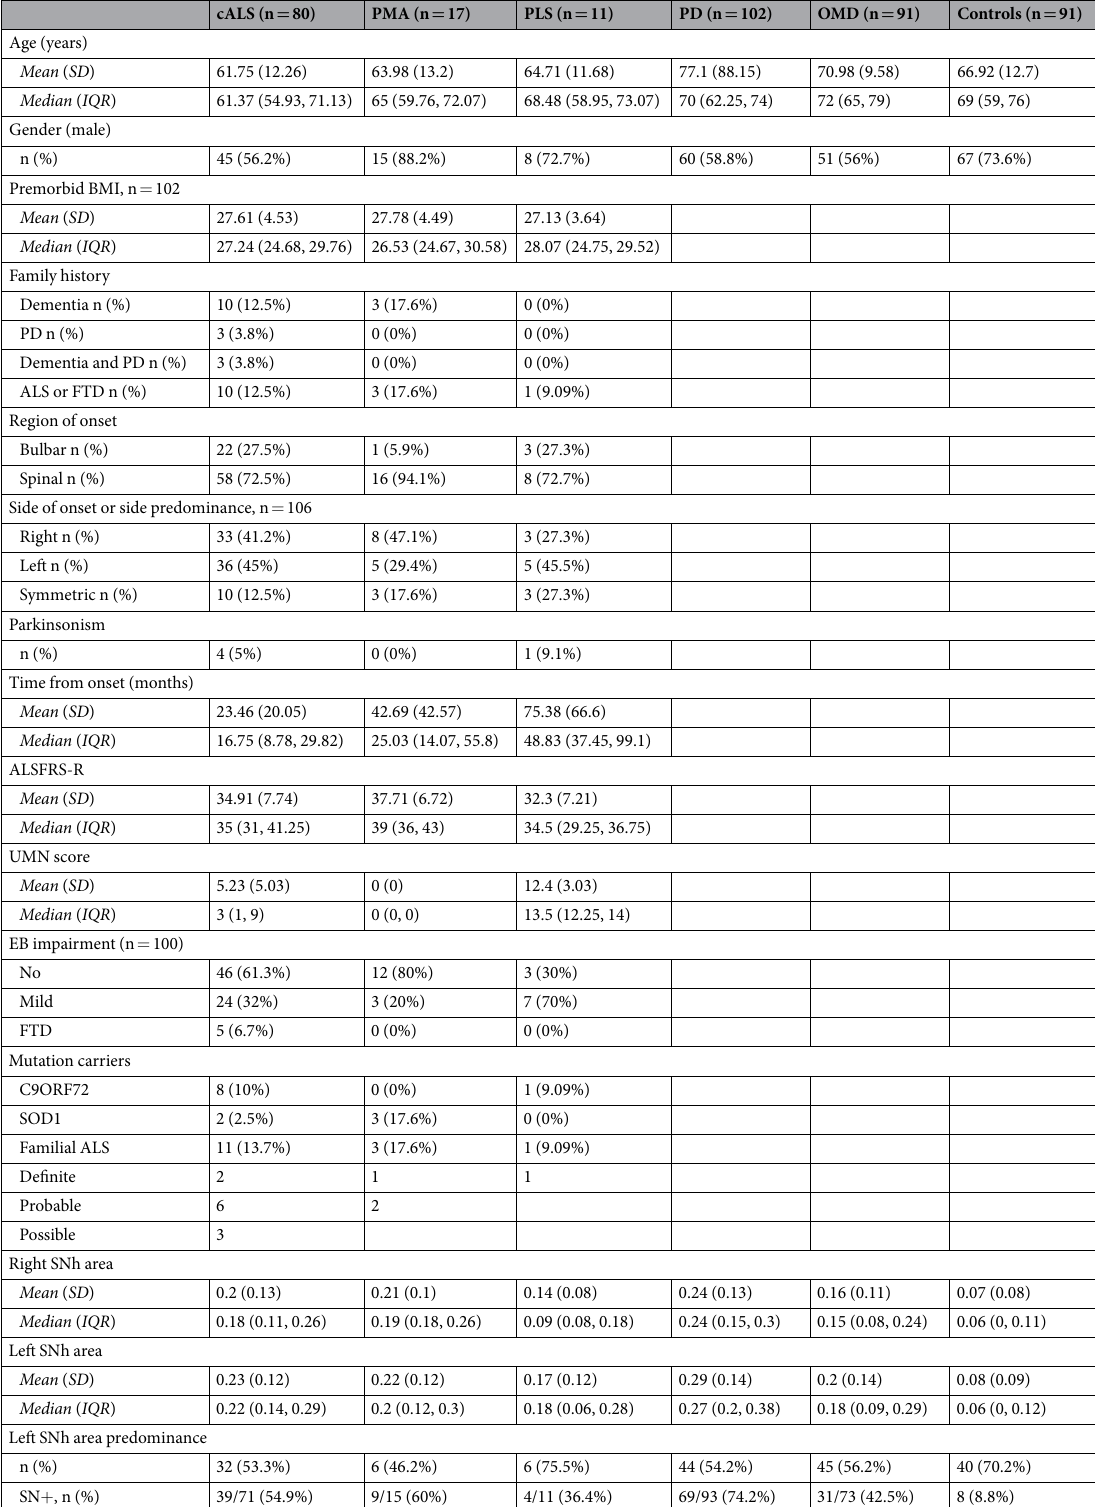
Table 1. Demographical, clinical and ultrasound characteristics of patients (as per phenotype) and controls. ALS: amyotrophic lateral sclerosis; BMI: body mass index; cALS: classical ALS; EB: executive or behavioural; FTD: frontotemporal dementia; OMD: other movement disorders (atypical parkinsonism, vascular parkinsonism and essential tremor); PD: Parkinson’s disease; PLS: primary lateral sclerosis; PMA: progressive muscular atrophy; SNh: hyperechogenicity of substantia nigra; SN + : hyperechogenicity of substantia nigra area > 0.22 cm 2 ; UMN: upper motor